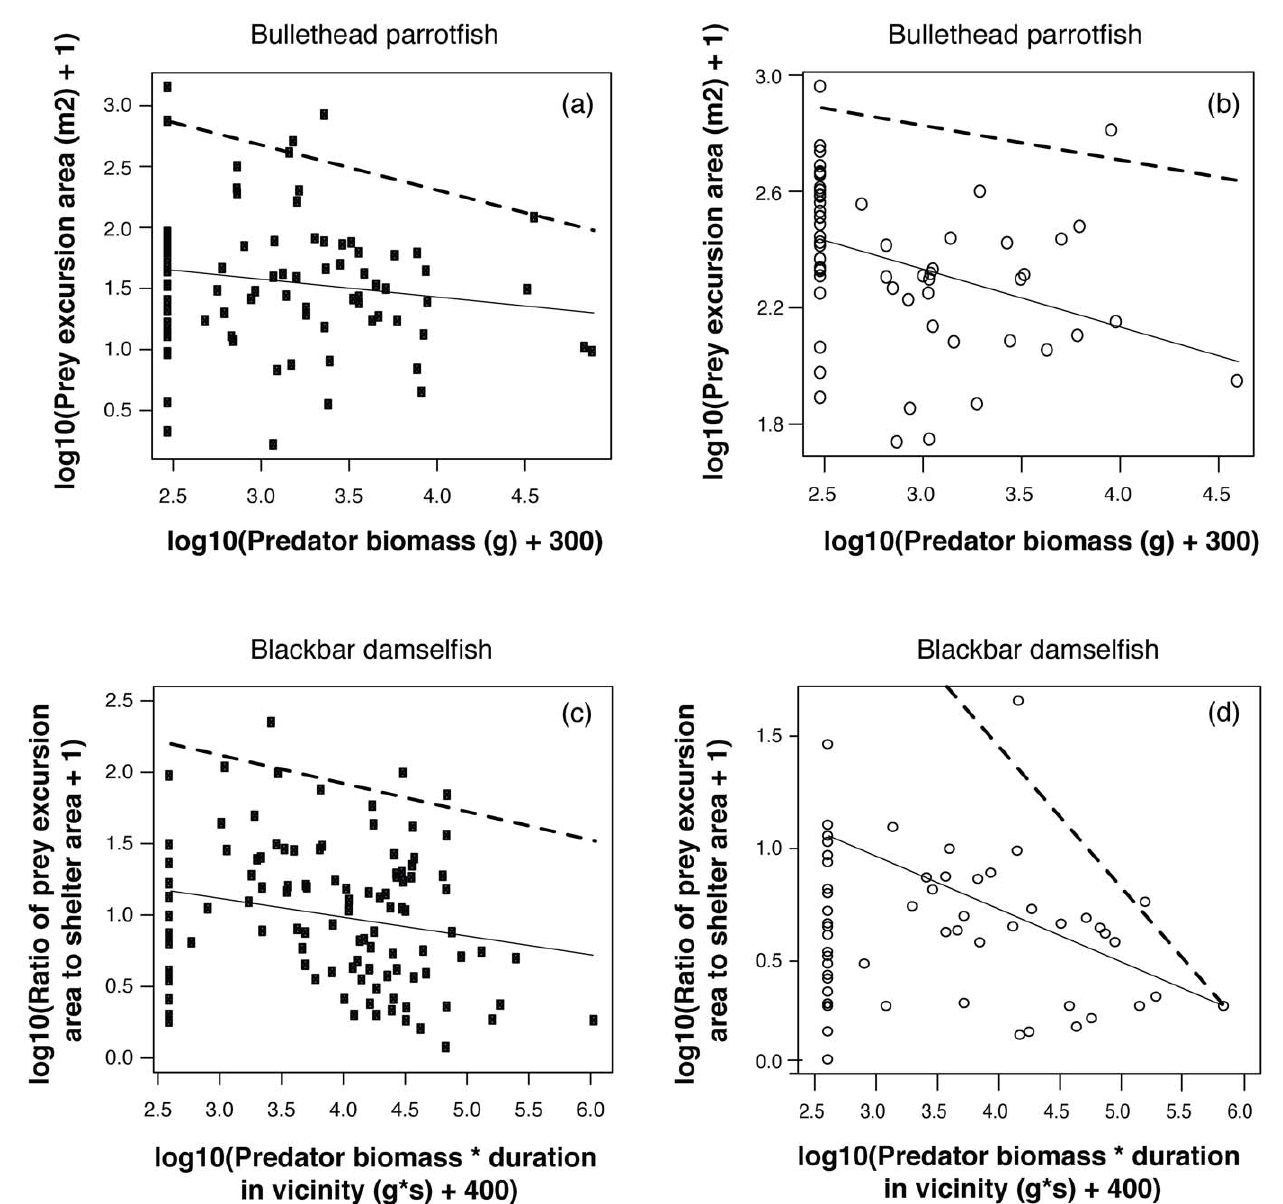
Figure 3. Prey excursion size and rate of movement in relation to acute predation risk for C.sordidus and P.dickii . Left-hand panels (a, c) show data from the Eastern Indo-Pacific (Line Islands); right-hand panels (b, d) are from the Central Indo-Pacific (GBR). Lines show best-fit upper 95% prediction intervals (dashed) and linear regressions (solid) based on a negative log-likelihood optimization function. Points are values for individual prey where predation risk is measured by predator biomass for C. sordidus and predator (biomass 6 duration) for P. dickii . Eastern Indo- Pacific (right-hand) panels are reproduced with permission from Madin et al. [13].